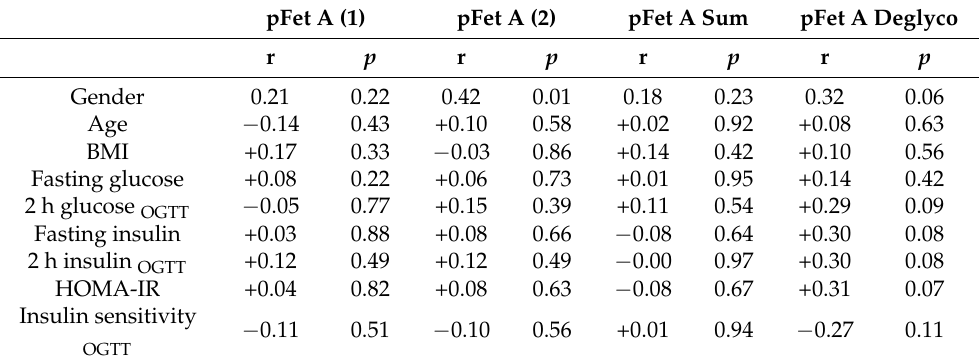
Table 3. Univariate associations of densitometric results obtained from Western blots of 35 indi- viduals (Figure 5) for pFet A, band (1) and band (2), and deglycosylated Fet A.